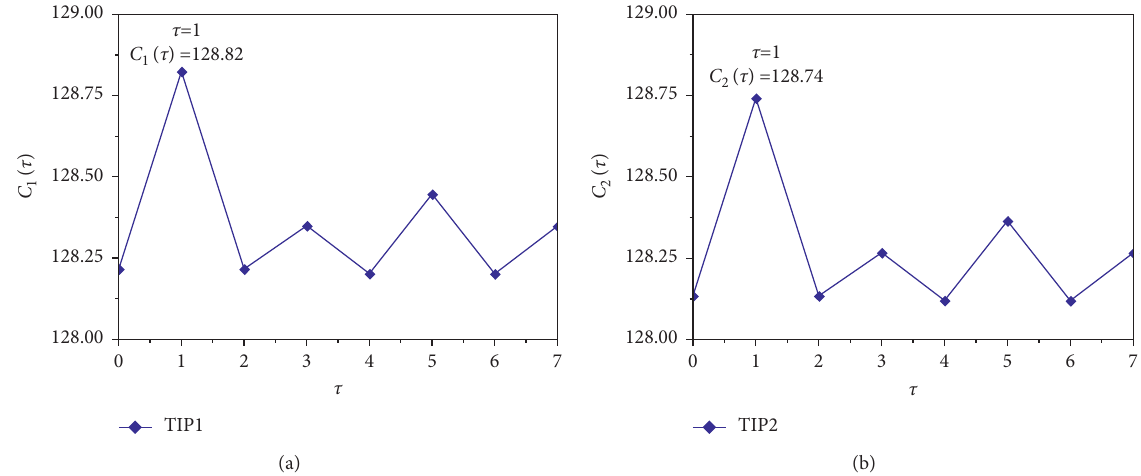
Figure 7: Correlation function calculation under nonresonant experimental condition of 2000r/min. (a) TIP1 sensor. (b) TIP2